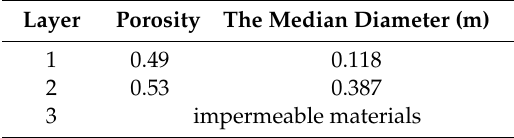
Table 3. The porous flow parameter for rubble mounted layers.